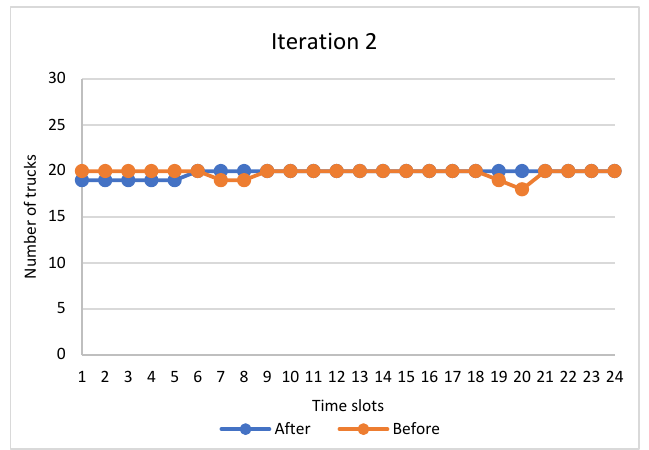
Figure 8. The workload before and after applying balancing constraint on iteration 2.